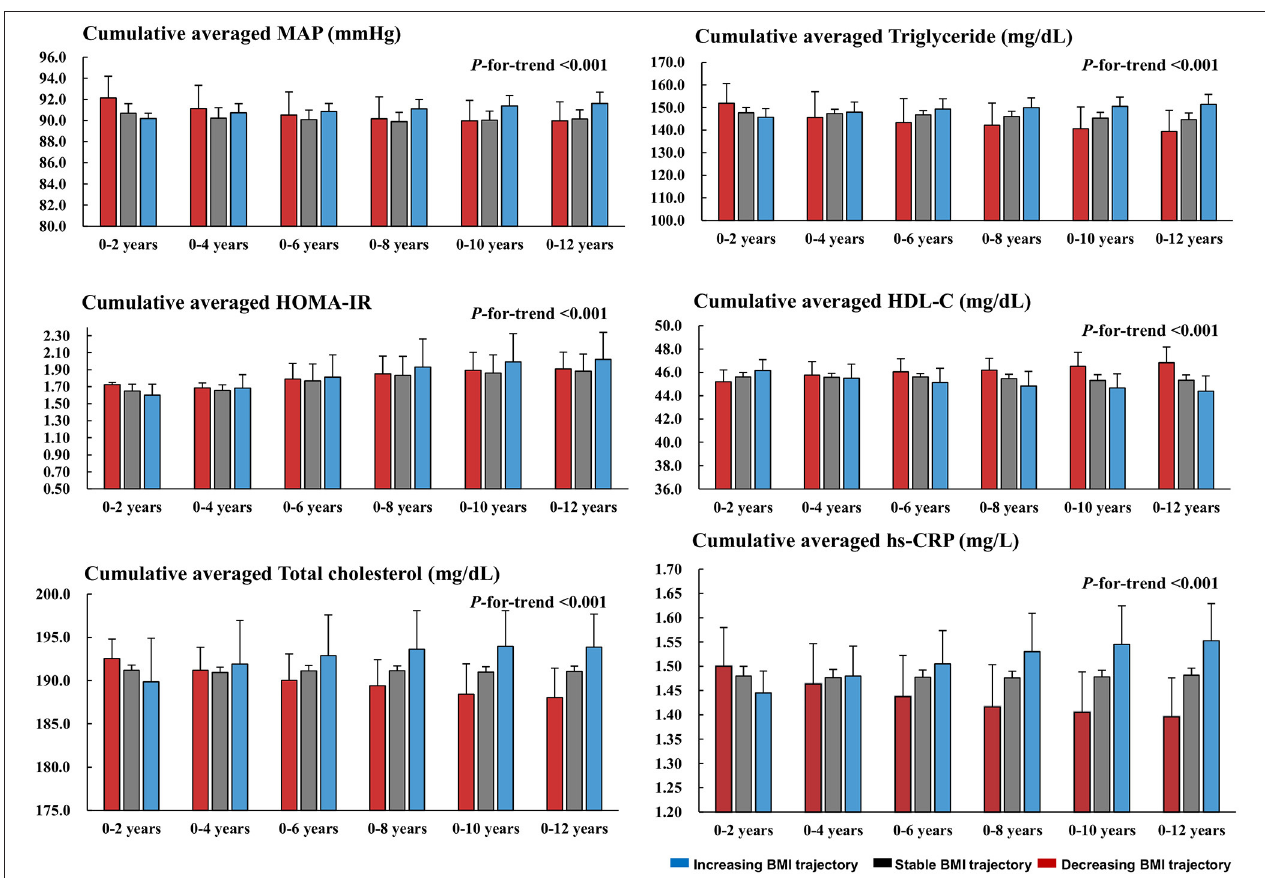
FIGURE 4 | Longitudinal changes in the MAP, HOMA-IR, and metabolic profiles across the trajectories. Cumulative averaged values of MAP, HOM-IR, lipid profiles, and hs-CRP were calculated as the mean of measurements of each parameter during the follow-up period. MAP, mean arterial pressure; HOMA-IR, homeostasis model assessment for insulin resistance; HDL-C, high-density lipoprotein-cholesterol; hs-CRP, high-sensitive C-reactive